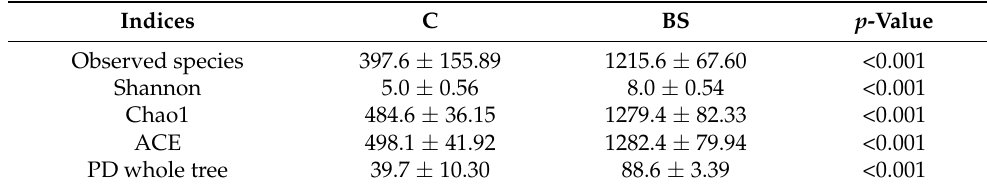
Table 3. Alpha indices (mean ± SE; n = 5) of observed species, Shannon, Chao1, ACE, and PD whole tree in the rumen fluid of lambs fed basal diet only (Control; C) or basal diet supplemented with Bacillus subtilis at the concentration of 3 × 10 8 CFU/kg DM (BS).